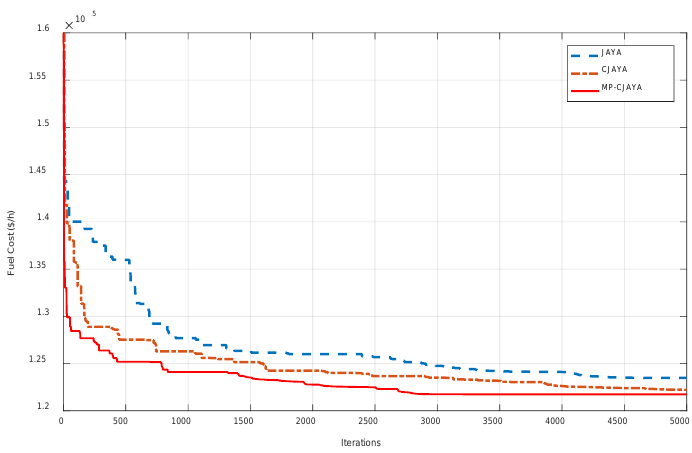
P = 10500 MW). P = 10500 MW). D D